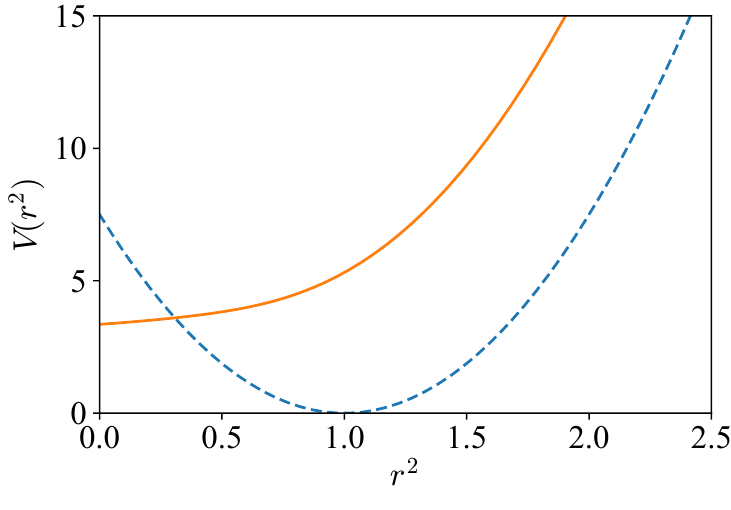
Figure 5 . Effective potential at θ = 0 evolved from k = Λ to k = 10 − 3 (where Λ = 3000 ). The dotted curve represents the initial form of the effective potential, V Λ , in eq. (3.25) with g = 30